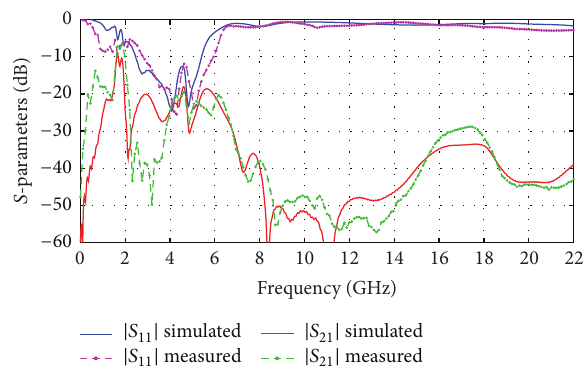
Figure 6: Magnitude of the antenna scattering parameters versus frequency.